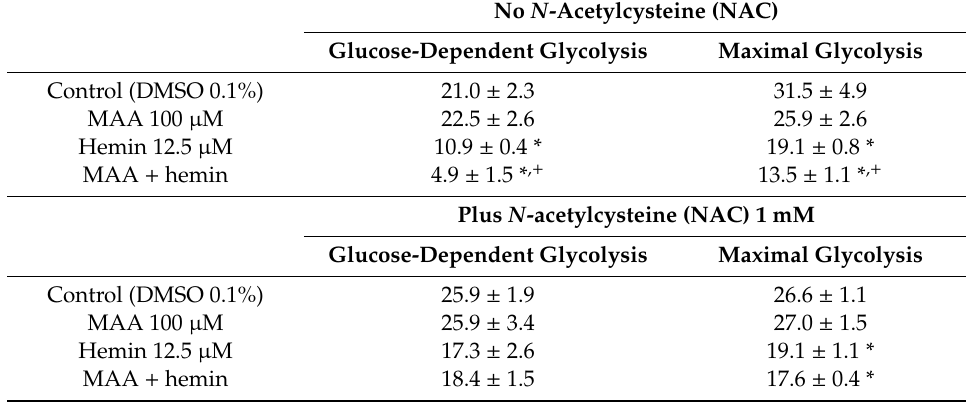
Table 1. Quantification of glycolysis by HL60 cells. The corresponding traces are shown in Figure 4B (no NAC) and Figure 4C (plus NAC 1 mM). HL60 cells were treated with the toxicants for 24 h. Glycolysis was determined as the extracellular acidification rate (ECAR) in the supernatant as the drop in pH (expressed as mpH) per min in the presence of 10 mM glucose (glucose-dependent glycolysis) or glucose and 1 µ M oligomycin (maximal glycolysis). Values are presented as the mean ± SEM of n = 4 independent observations in triplicate. * p < 0.05 vs. vehicle-treated control incubations (DMSO 0.1%). + p < 0.05 vs. hemin 12.5 µ